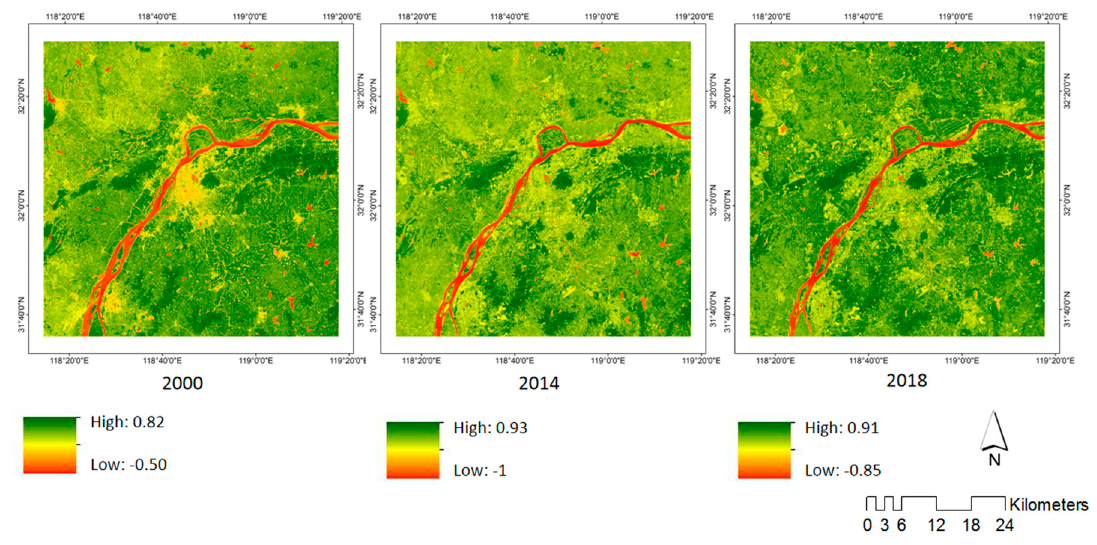
Figure 5. Normalized Difference Vegetation Index (NDVI) maps of Nanjing in 2000, 2014, and 2018.